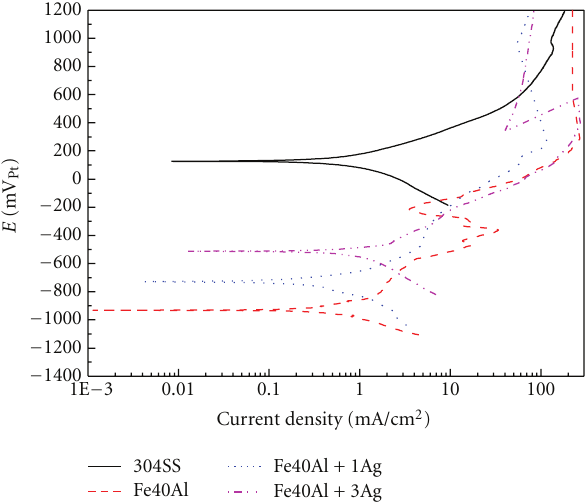
Figure 1: E ff ect of Ag, Li, Cu, and Ni on the weight loss for Fe40Al alloy in NaCl-KCl (1:1 molar ratio) deposit in static air at 670 ◦ C.